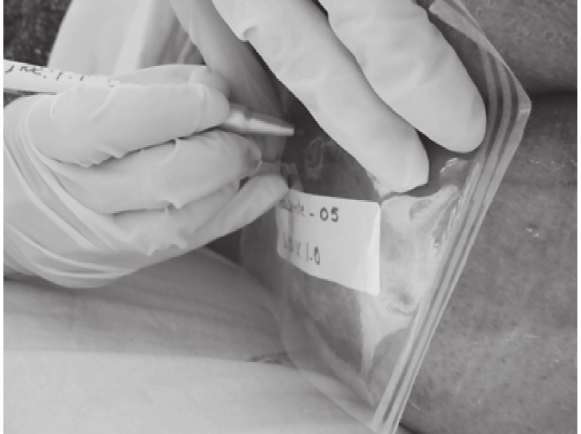
Figura 1 – Delimitação do contorno da área da úlcera no acetato Fonte: Dados da pesquisa.